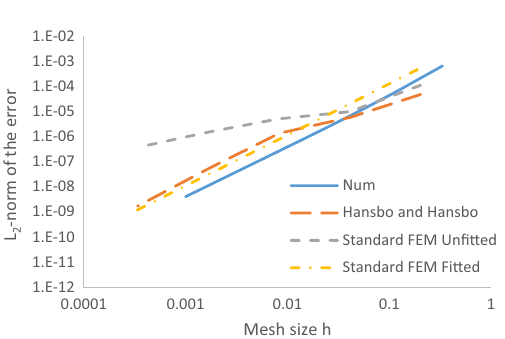
Fig. 14 Comparison of the convergence of present approach to Hansbo and Hansbo [19] and the standard FEM with a fitted and unfitted mesh